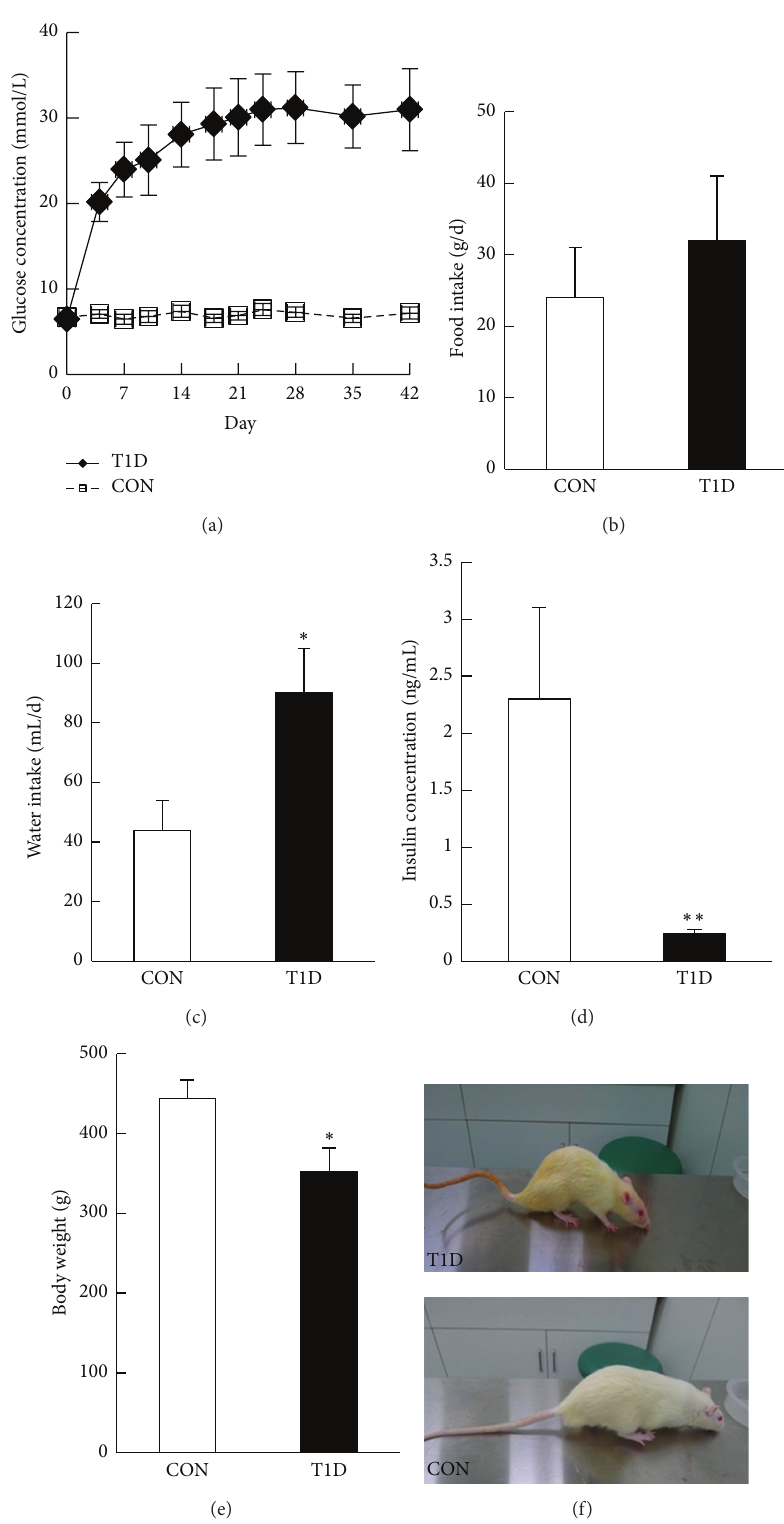
Figure 1: (a) Plasma glucose concentrations were observed for the 6 weeks after STZ or sodium citrate buffer treatment. (b and c) Intake of food and water per day in type 1 diabetic (T1D group) and nondiabetic rats (control group) after 6 weeks of treatment with STZ. (d) Nonfasting plasma insulin concentrations in type 1 diabetic and nondiabetic rats after 6 weeks of treatment with STZ. (e and f) T1D rats showed significantly reduced body weight along with dismal hair, irritability, and weakness after 6 weeks of treatment with STZ. ∗∗ 𝑃 < 0.01 , ∗ 𝑃 < 0.05 between the two